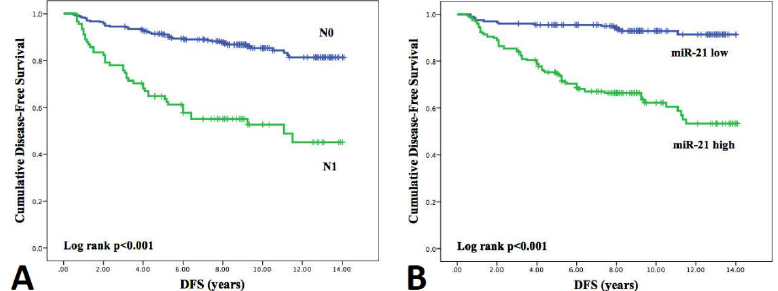
Figure 7. Kaplan–Meier curves estimating disease-free survival according to ( A ) the presence of lymph node metastasis and ( B ) high/low expression levels of miR-21. DFS curves were compared using the Log rank test.